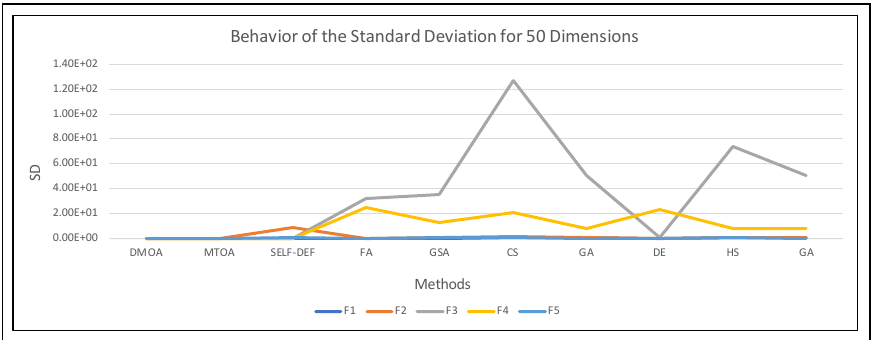
Figure 13. Behavior of the Standard Deviation of the DMOA Algorithm and the methods: MTOA, Self Defense, FA (FireFly Algorithm, GSA, CS, GA, DE, HS, and GA for 50 dimensions.